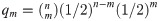
Markov chain describing the state transition that detectors undergo during training considering the immunological model.In this representation, n describes the number of top positions to be corrected in a list of size N, Wm the waiting states, that represent a list with m correctly ranked items on the top n positions and E the education state. The probability of transition from the list education state E to the waiting states, Wm, is qm=(nm)(1/2)n−m(1/2)m. The transition probability from a waiting state, Wm, to the education state, E, is qeduc = (n − m)/N.